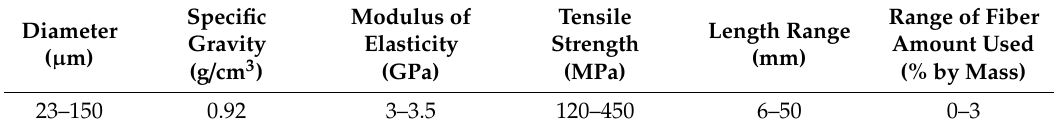
Table 1. Basic properties of polypropylene fibers